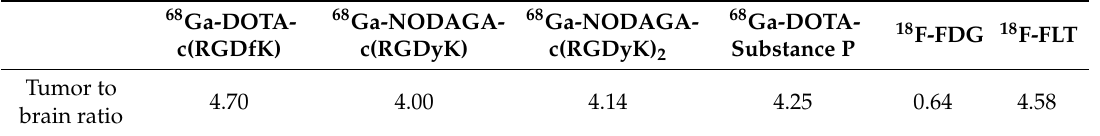
Figure 4. 3D volume rendered PET / CT images of ( A ) 68 Ga-DOTA-c(RGDfK), ( B ) 68 Ga-NODAGA- c(RGDyK), ( C ) 68 Ga-NODAGA-c(RGDyK) 2 , ( D ) 68 Ga-DOTA-substance P, ( E ) 18 F-FDG and ( F ) 18 F-FLT in mice bearing U-87 MG xenograft tumor on the right flank 90 min p.i. of the tracer. Yellow arrows are indicating the position of the tumor. Table 3. Tumor to brain ratios calculated from positron emission tomography (PET) data (standard uptake values (SUV) of respective regions) acquired 90 min p.i. of the